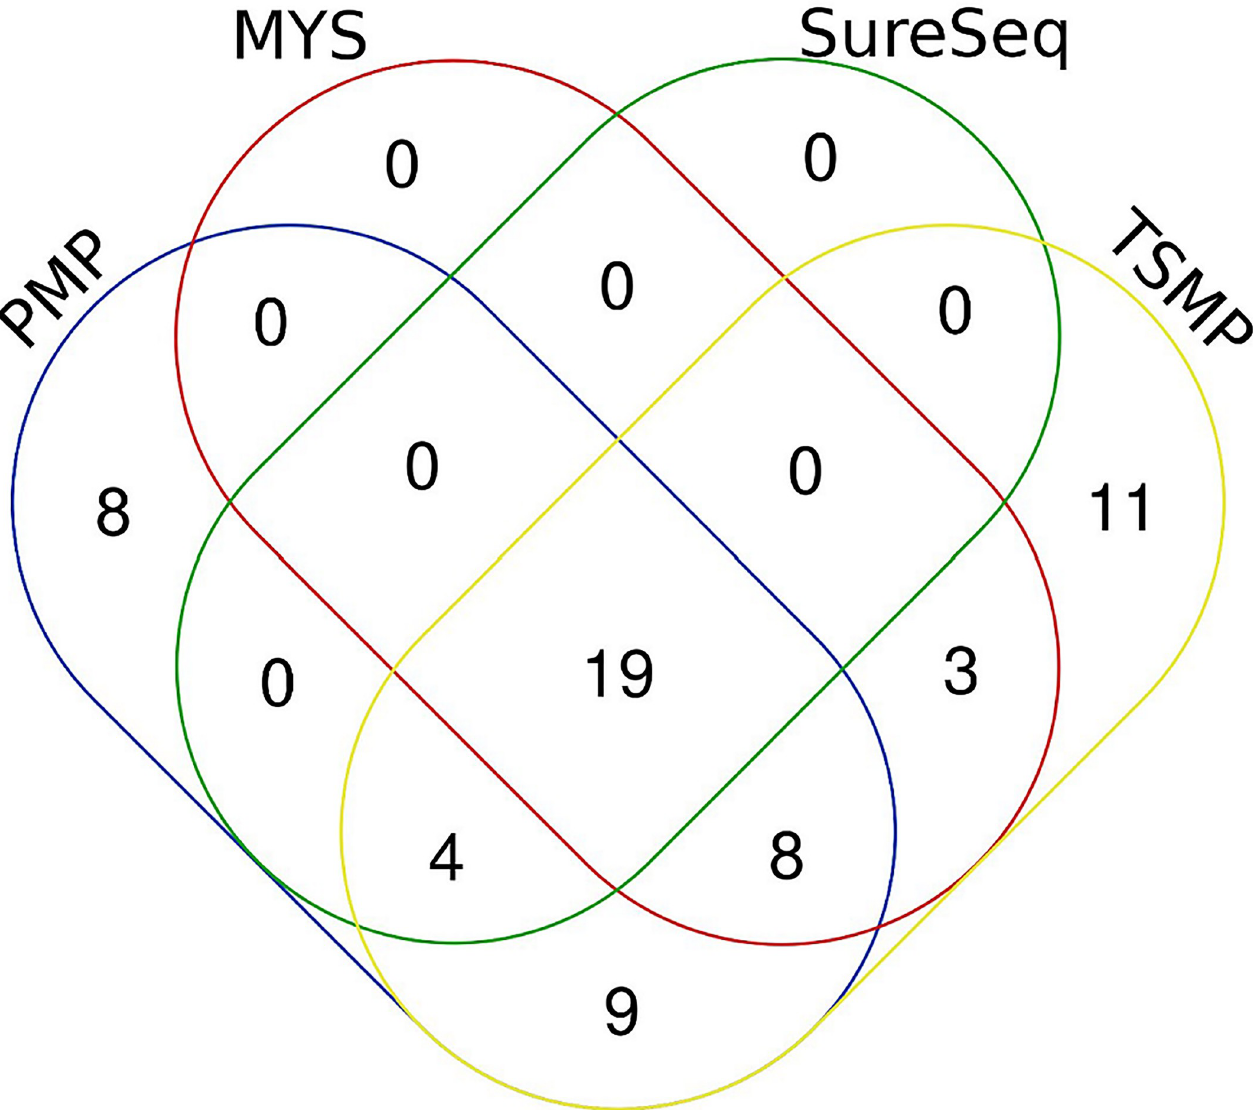
Fig 3. Number of genes shared between panels. All four panels covered the same 19 genes (core myeloid gene set). TSMP, PMP and Sureseq panels design includes 4 genes not targeted by MYS. PMP, TSMP and MYS panels target 8 genes not included in SureSeq panel design. TSMP and PMP cover 9 genes that are not within MYS and SureSeq panel scope. TSMP and MYS panels cover 3 genes not included in the other two panels.